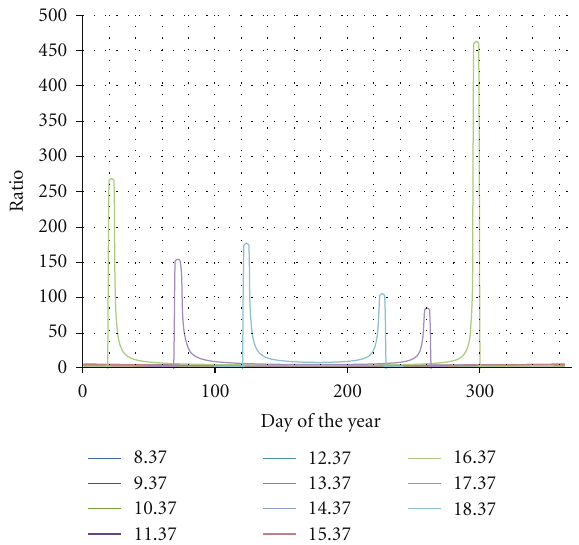
Figure 22: Ratio of mirror 6 along the year (shadows are consid- ered).